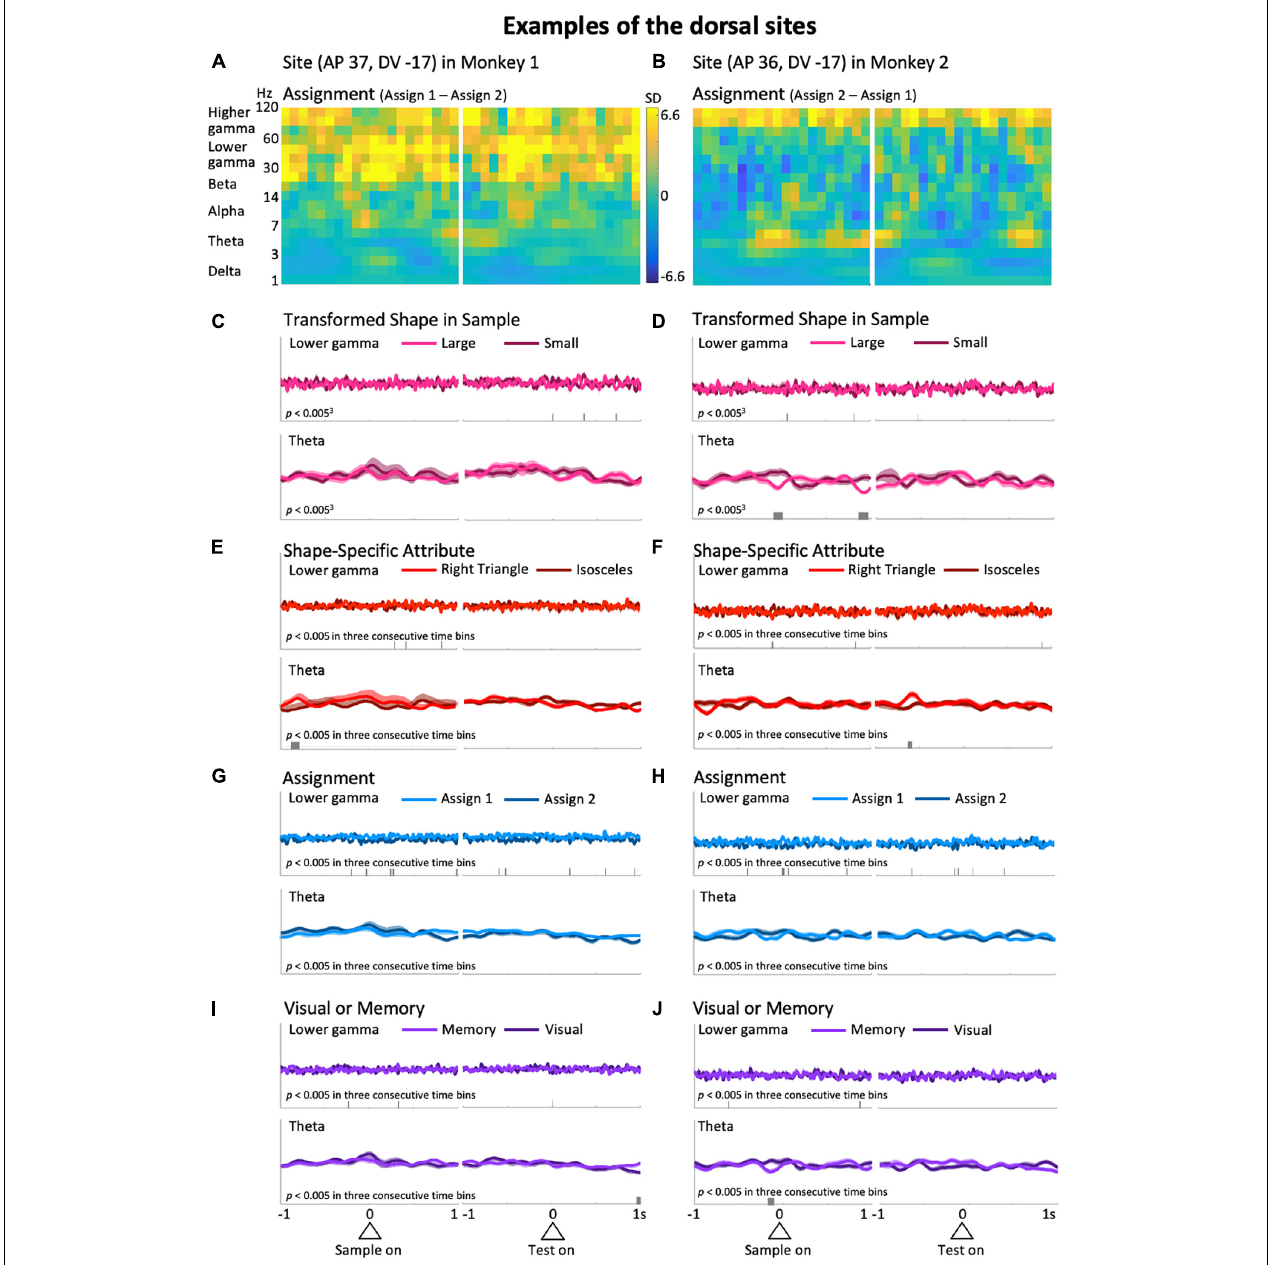
FIGURE 4 | Typical examples from the dorsal side of the LFPC in Monkeys 1 (left column: AP 37, DV -17) and 2 (right column: AP 36, DV -17). (A,B) Differences of the time-frequency spectra between assign 1 and assign 2. (C–J) Same as the corresponding plots in Figure 3 . The scales for the mean upper envelopes are identical in each column. Small bars in each mean upper envelope plot indicate the time regions of significant differences ( p < 0.005) in three consecutive time